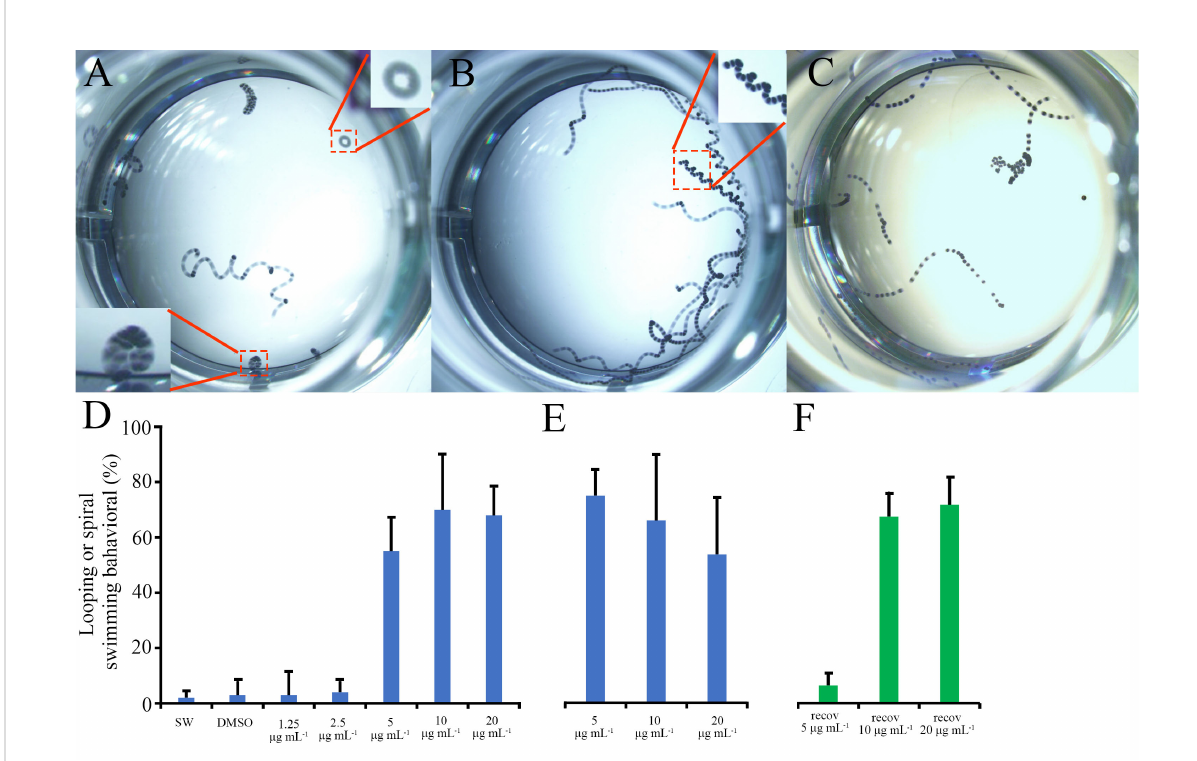
FIGURE 2 Bugulina neritina larval swimming behavior analysis. (A – C) Representative overlaid images of all frames of a 10 seconds video which recorded the larval swimming behavior after 1.5 hours of BU treatment. (A) Looping swimming behavior of B. neritina larvae in 10 m g mL -1 BU treatment. (B) Spiral swimming trajectory of B. neritina larvae in 5 m g mL -1 BU treatment. (C) The swimming trajectory of B. neritina larvae in the control group. (D, E) The percentage of larvae exhibiting looping or spiral swimming behavior at (D) 1.5 hours and (E) 6 hours of BU treatments. (F) The percentage of larvae exhibiting looping or spiral swimming behavior at 1 hour after recovery from 3 hours BU treatments in the recovery